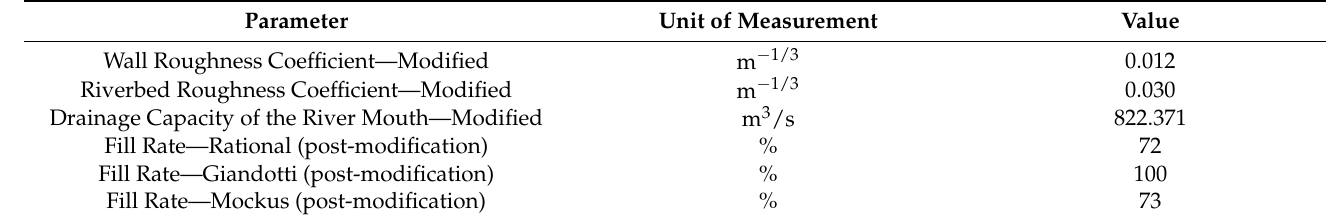
Table 9. Modification of the roughness coefficient.